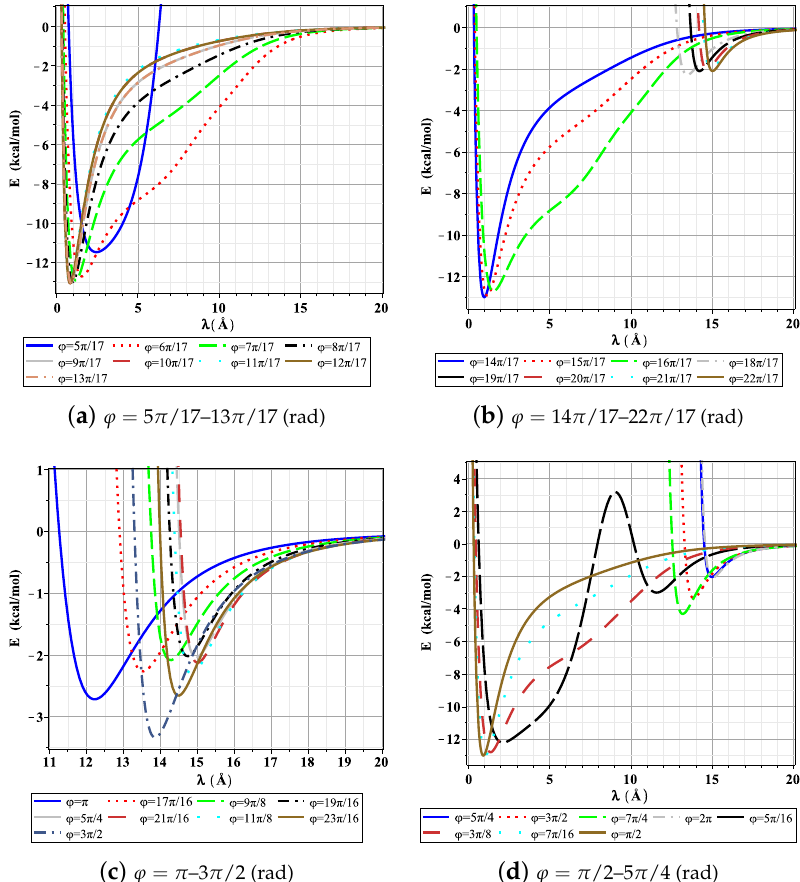
Figure 5. Energies of Cis binding to DNA with respect to λ for ψ = 12 π /17.